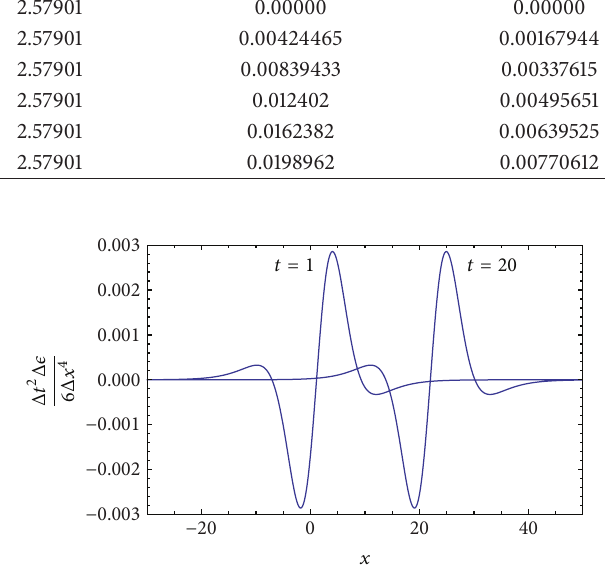
Table 4: Table comparing values obtained from the nonstandard numerical scheme (40) to the single solitary wave solution (8) for 𝑥 0 = 0 and 𝑣 = 0.1 , for 𝑥 ∈ [−50, 70] , and taking 𝑛 = 5000 and Δ𝑡 = 0.0001 . Time 𝐼 1 𝐼 2